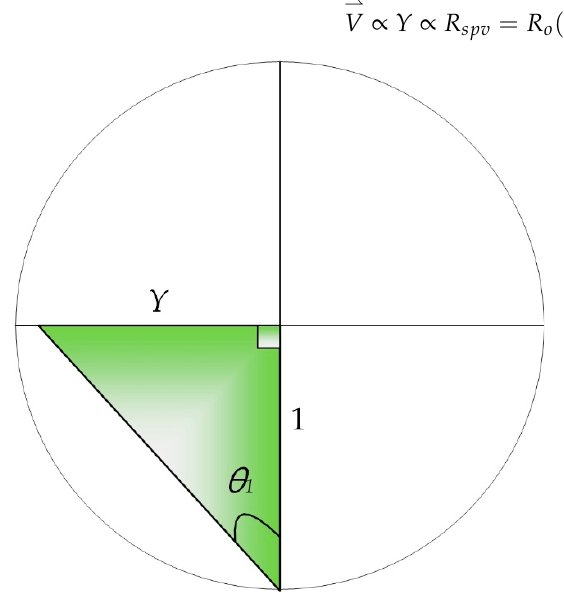
Figure 8. The relationship diagram of angle θ 1 and its opposite Y .